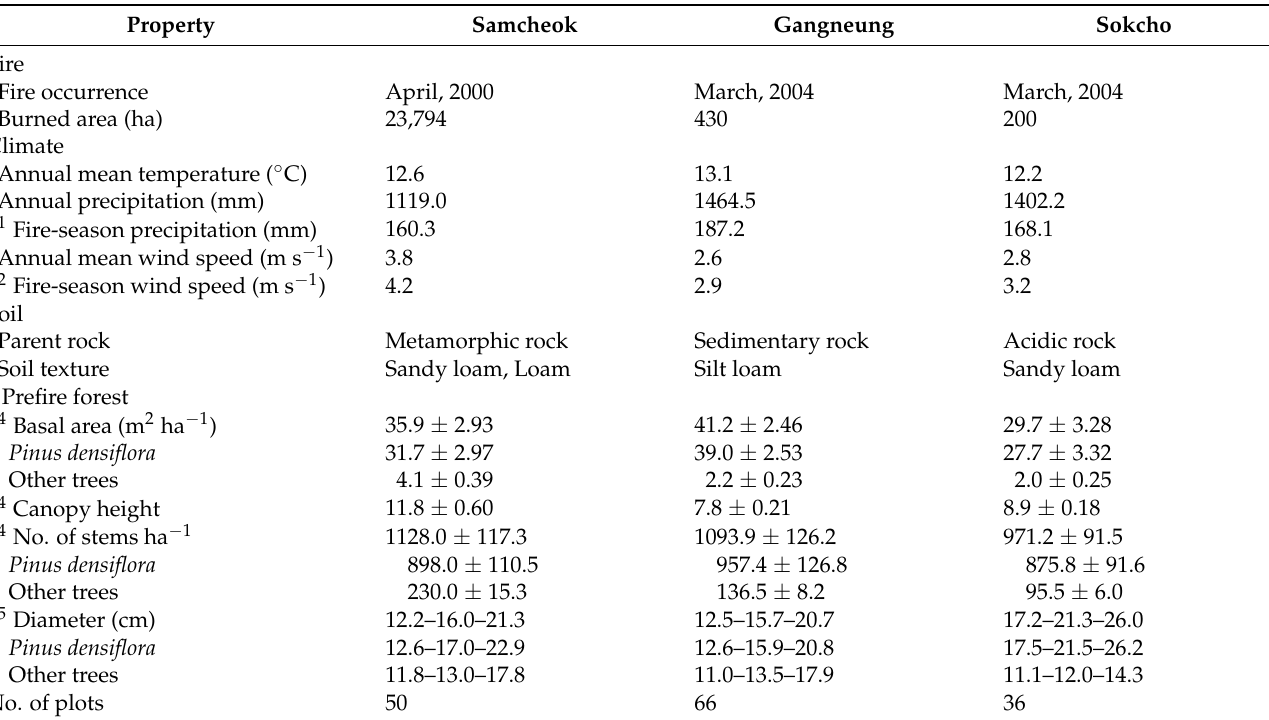
Table 1. Characteristics of fire occurrence, climate, soil, and prefire forest in three study